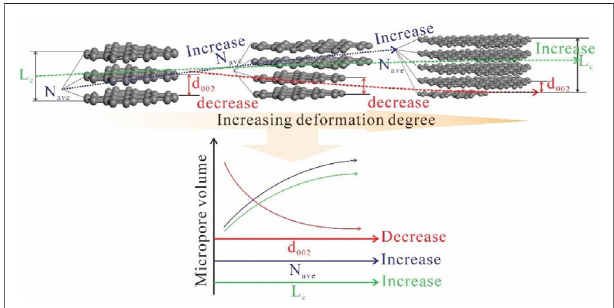
FIGURE 13 | Micropore variation with macromolecular structure evolution